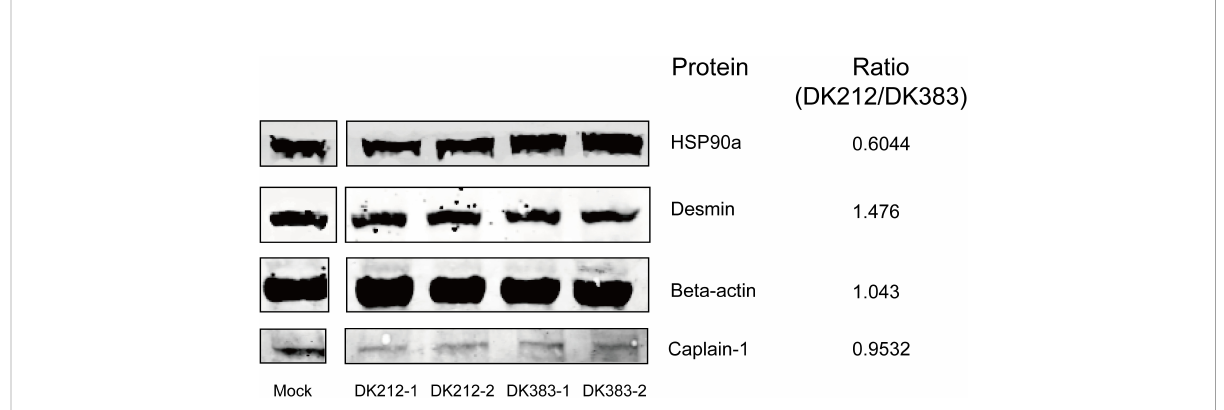
FIGURE 6 Western blot analyses of the representative proteins. Ratios of each protein between DK212 and DK383 were determined by iTRAQ. Compared with the DK383 group, decreased expression was observed for HSP90a, increased expression was found for desmin, and the expression of b -actin and caplain-1 were not altered in the DK212